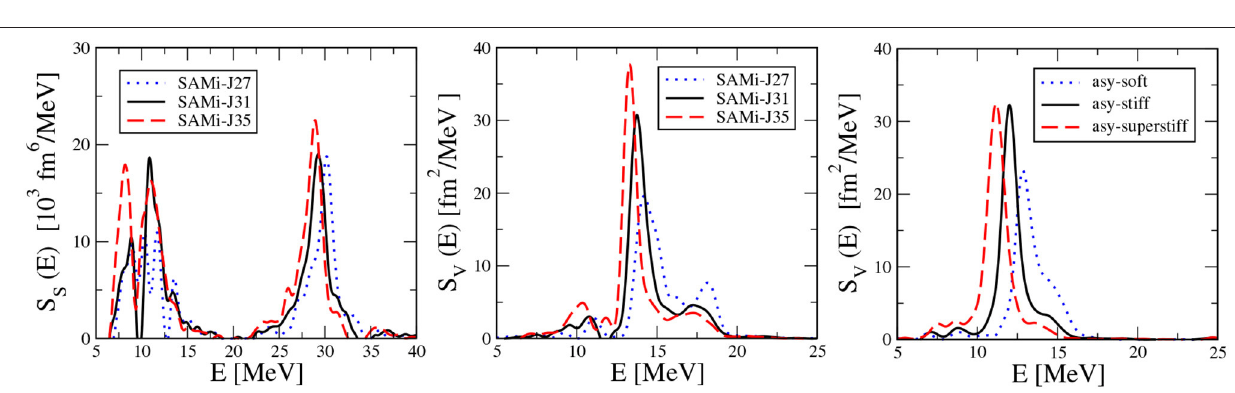
FIGURE 6 | (Color online) The IS (Left) and IV (Central) strength function versus excitation energy for 132 Sn and the three considered SAMi-J interactions. Right : the same as for the Central , but employing momentum-independent interactions. Readapted from Zheng et al.